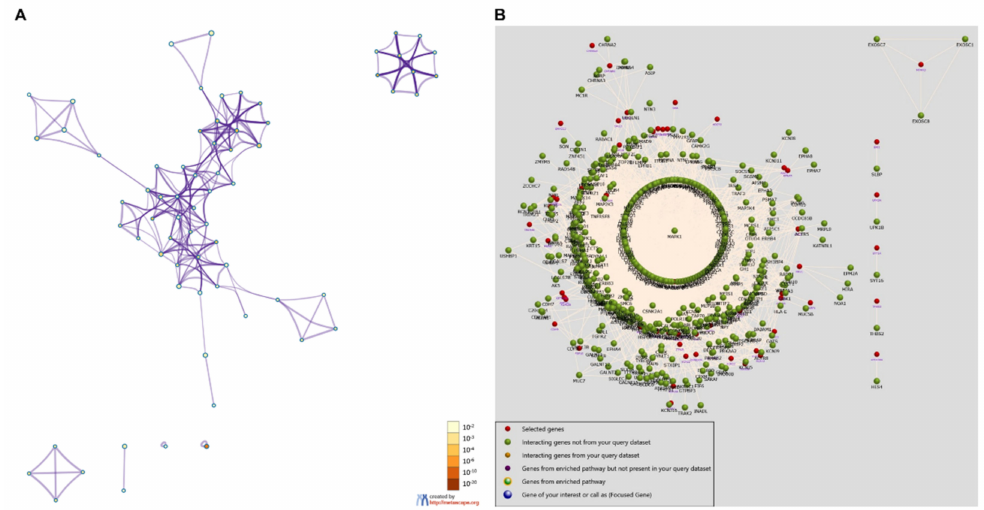
Figure 7. Interactions between genes and a network layout of the KEGG and GO clusters: ( A ) gene clusters; ( B ) network of gene